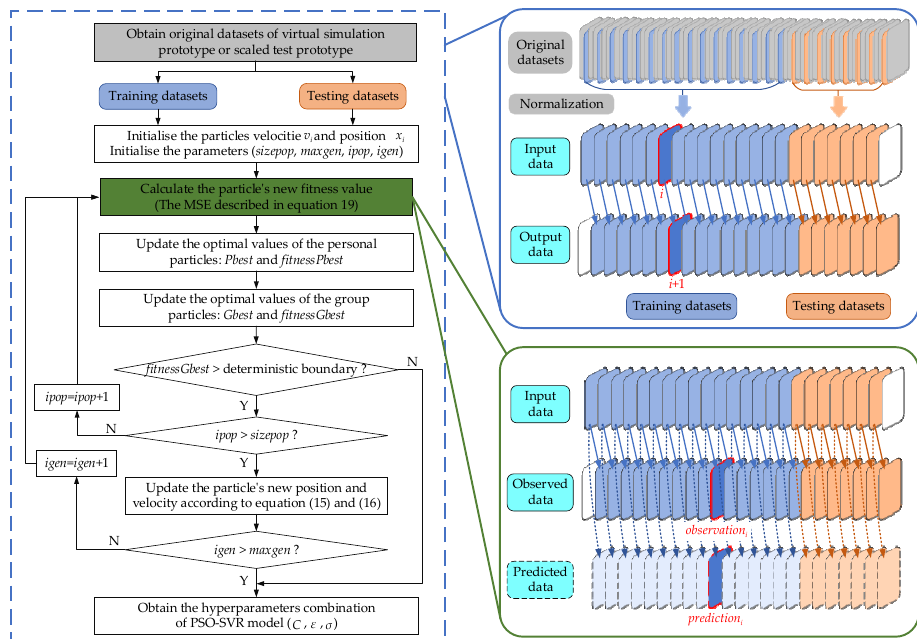
Figure 6. Flowchart of PSO-SVR modelling and prediction.